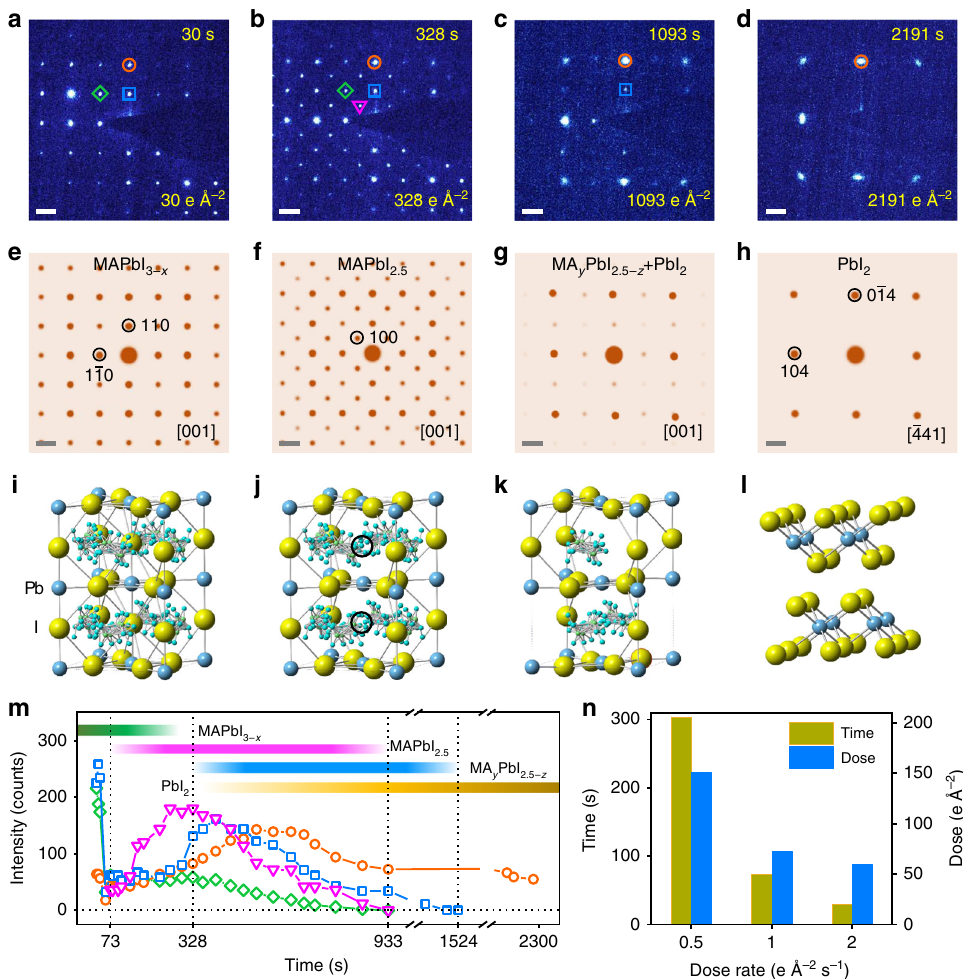
Fig. 5 The structural evolution during the decomposition from MAPbI 3 to PbI 2 . a – d Time-series SAED patterns showing that the structure decomposes from a MAPbI 3 – x [001] zone axis (0 < x < 0.5), to b intermediate phase MAPbI 2.5 , c MA y PbI 2.5 – z (0 ≤ y ≤ 1 and 0 ≤ z ≤ 0.5), and d PbI 2 [ (cid:1) 441] zone axis sequentially under a dose rate of 1 e Å − 2 s − 1 . The cumulative electron dose and time are labeled in each pattern. The blue squares mark the (110) re fl ection of MAPbI 3 in a , MAPbI 2.5 in b , and MAPbI 2.5 and MA y PbI 2.5 – z in c . The green diamonds mark the (200) re fl ection of MAPbI 3 in a , and MAPbI 2.5 in b . The orange circles mark the (220) re fl ection of MAPbI 3 in a , MAPbI 2.5 in b , MAPbI 2.5 and MA y PbI 2.5 – z in c , and (0 (cid:1) 14) of PbI 2 in d . The pink triangles mark the (100) re fl ection of MAPbI 2.5 in b . e – h The corresponding simulated ED patterns of e MAPbI 3 , f MAPbI 2.5 , g 35% MA y PbI 2.5 – z + 65% PbI 2 (see Supplementary Fig. 12), and h PbI 2 . Note that MA y PbI 2.5 – z (0 ≤ y ≤ 1 and 0 ≤ z ≤ 0.5) with random vacancies should have the same ED pattern with MA y PbI 2.5 – z ( y = 0 and z = 0.5) without considering the very diffused re fl ections from random vacancies. i – l The atomistic structures of i MAPbI 3 , plotted as a function of time (total dose). The pink triangles, orange circles, blue squares, and green diamonds correspond to those label shapes in a – d . The green, pink, blue, and orange color bars roughly estimate the existence of MAPbI 3 – x , MAPbI 2.5 , MA y PbI 2.5 – z , and PbI 2 at different stages. Note that the values of the intensities for (110) (blue squares) and (100) (pink triangles) spots are set to be 1.8 and 6 times of the original values for comparison. n During the decomposition of the perovskite at different dose rates, the measured critical electron dose and time for the appearance of a superstructure. Scale bar, 1 nm − 1 ( a – h